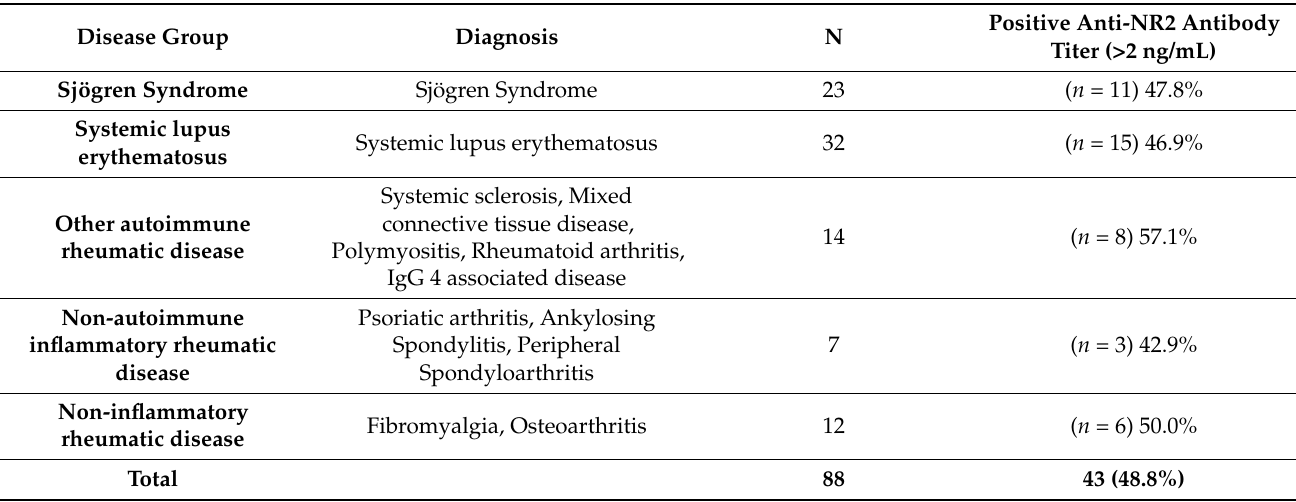
Table 2. Clinical characteristics of the patients and distribution of positive anti-NR2 antibody titer in the different groups of fatigued patients with rheumatic